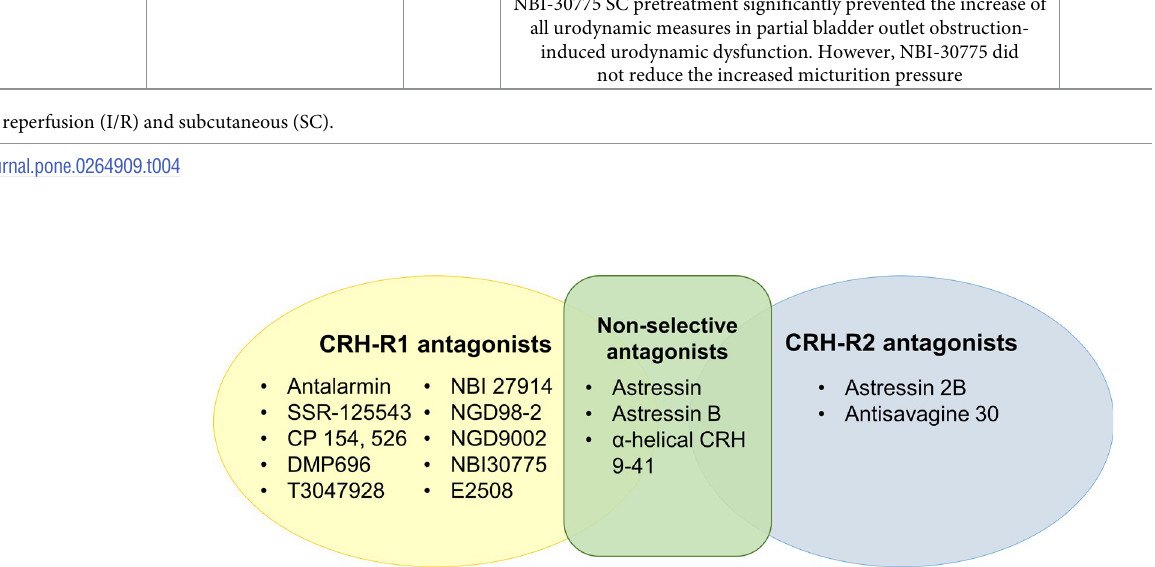
Fig 2. Compounds reported in the manuscripts reviewed. Ten compounds were used as CRH-R1 selective antagonists, while only two compounds were used as CRH-R2. Three non-selective CRH-R antagonists were reported in the